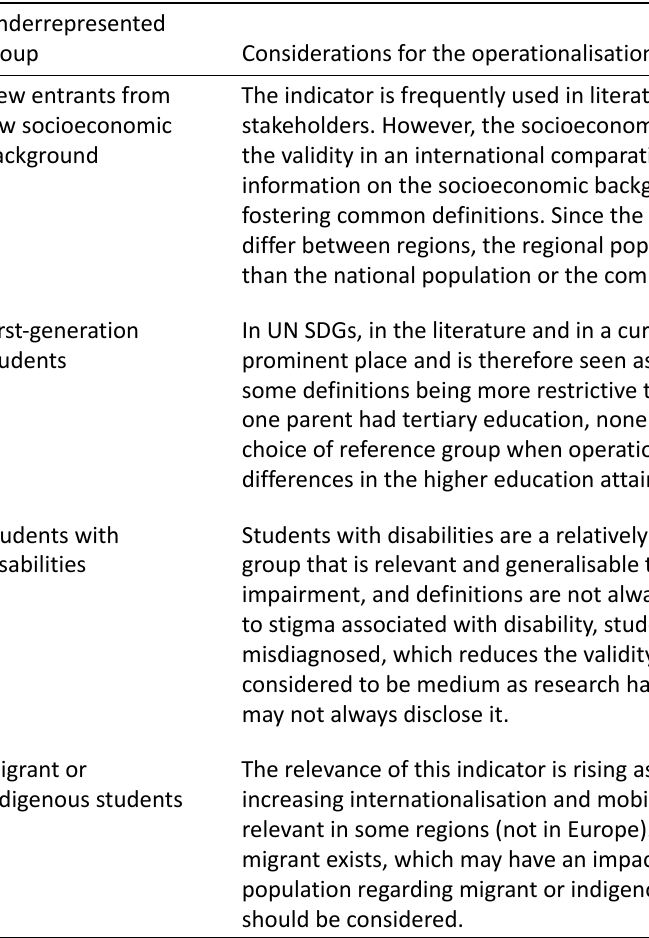
Table 2. Overview of underrepresented student groups and considerations for operationalisation, consolidated